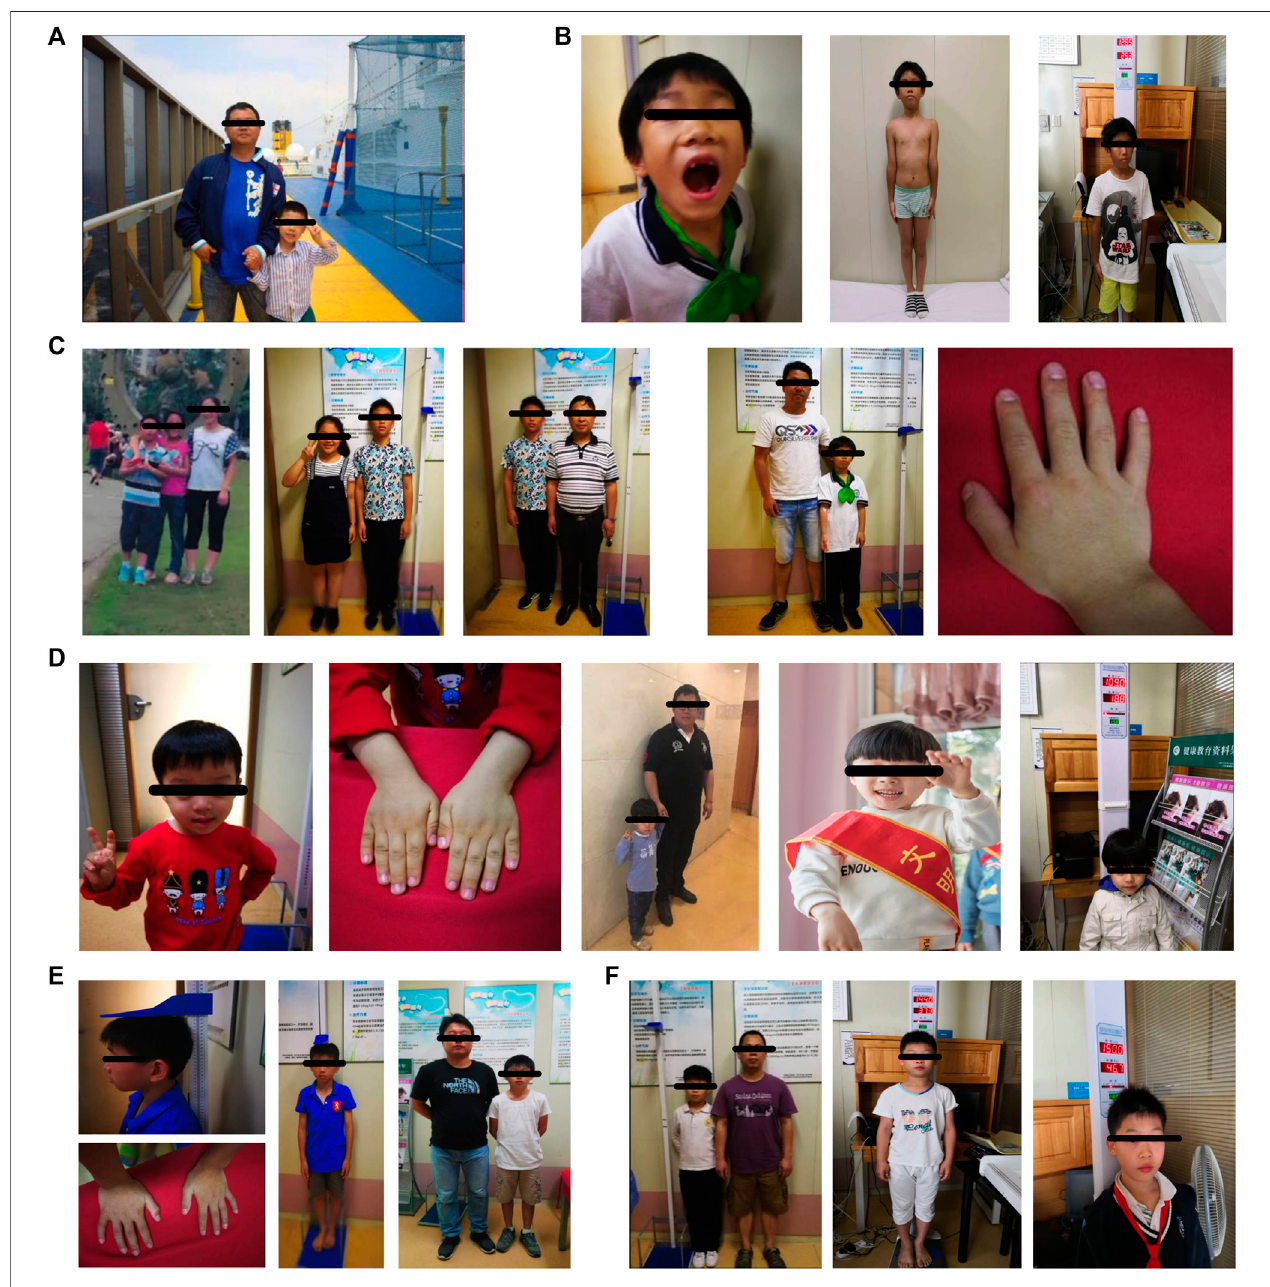
FIGURE 1 | Clinical features of the six cases ’ pro fi